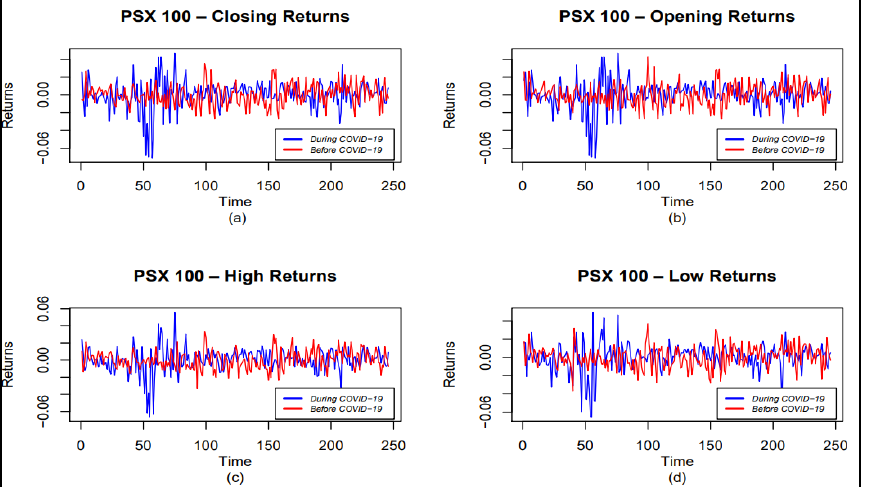
Figure 1. Volatility clustering of PSX-100 returns.